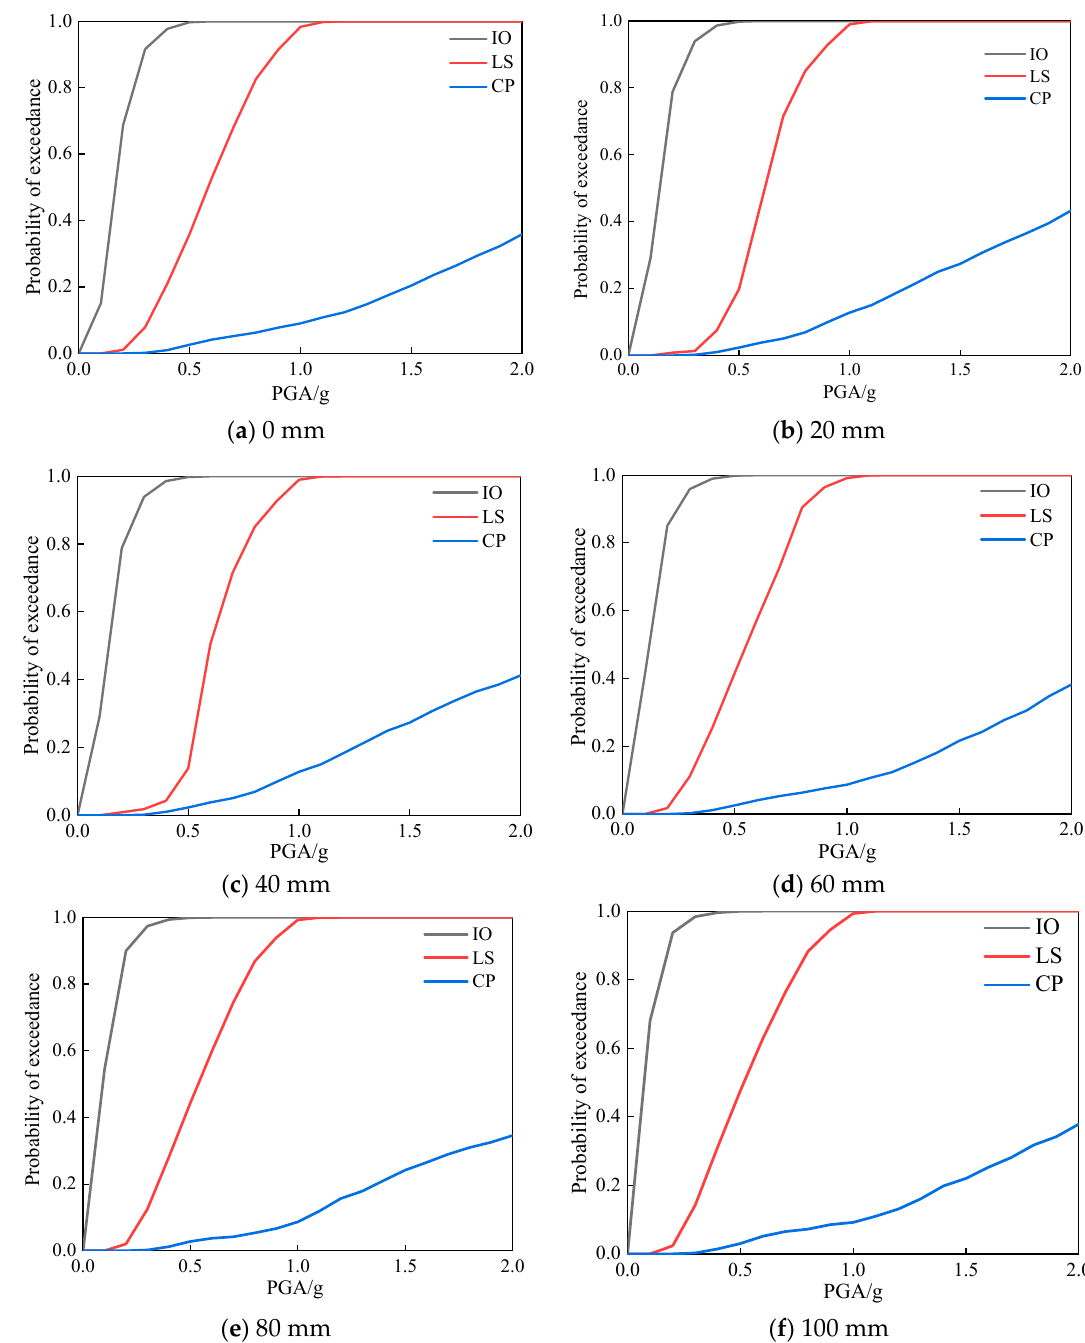
Figure 9. Fragility curves of structures with different uneven settlement quantities in Zone I.